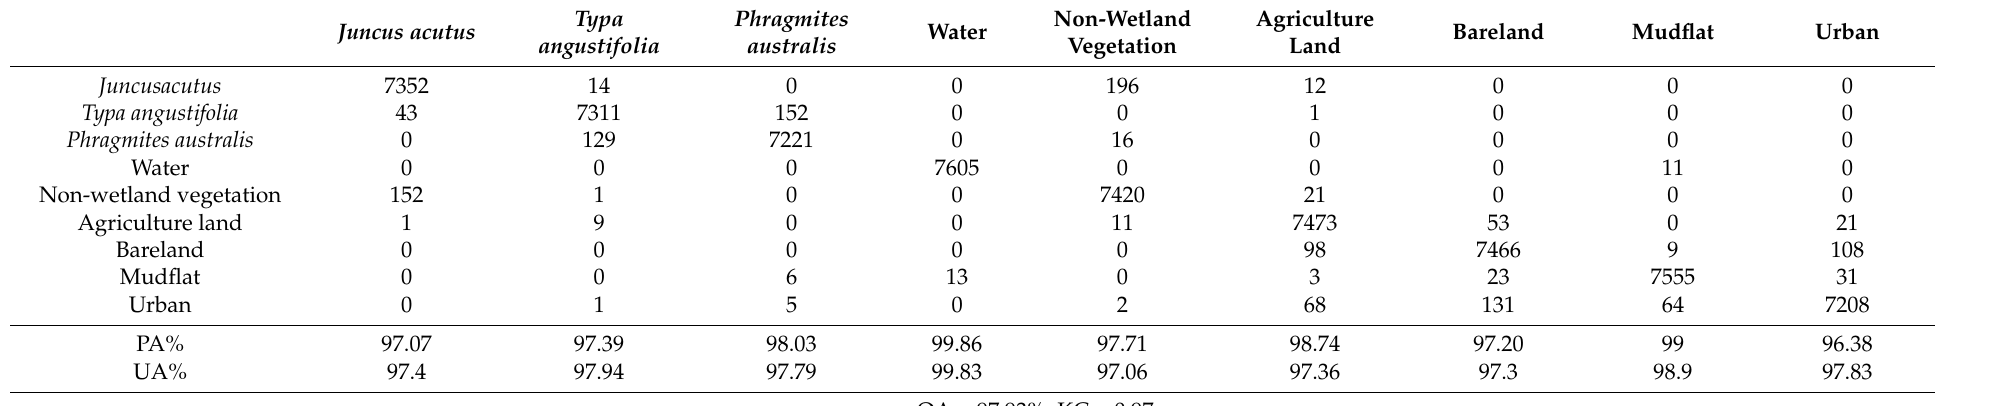
Table 3. Confusion matrix of the wetland map of the reference year